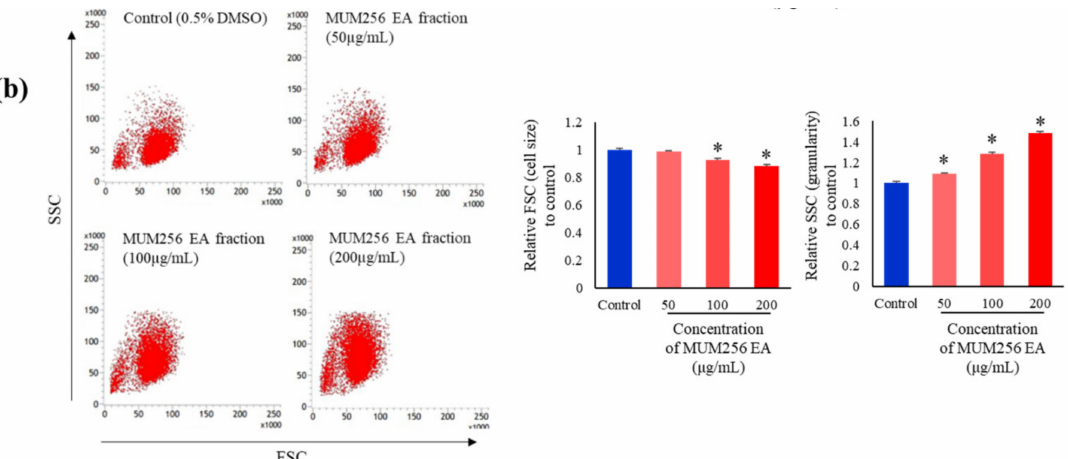
Figure 4. Morphological changes of HCT116 cells after exposure to MUM256 EA treatment. ( a ) Phase contrast microscopic evaluation of HCT116 cells under × 10 magnification. Decreased number of HCT116 cells were observed across the 3 timepoints with increasing concentration of MUM256 EA treatment. Furthermore, arrows indicate the rounded cells due to cytoplasmic shrinkage and detached cells which was increased in number with increasing concentration of MUM256 EA treatment. ( b ) Representative forward scatter / side scatter (FSC / SSC) dot plot of HCT116 cells after exposure to MUM256 EA at different concentrations. The x-axis shows a decreasing FSC in HCT116 cells treated with increasing concentrations of MUM256 EA. The FSC represents the diffracted light and it is related to cell size. The y-axis shows an increasing SSC in HCT116 treated with increasing concentrations of MUM256 EA. The SSC represent the reflected and refracted light and is related to cell granularity and complexity. The bar graphs show the relative median FSC and SSC fluorescence signals of treated cell population as compared to control ± SD (n = 3, * p <